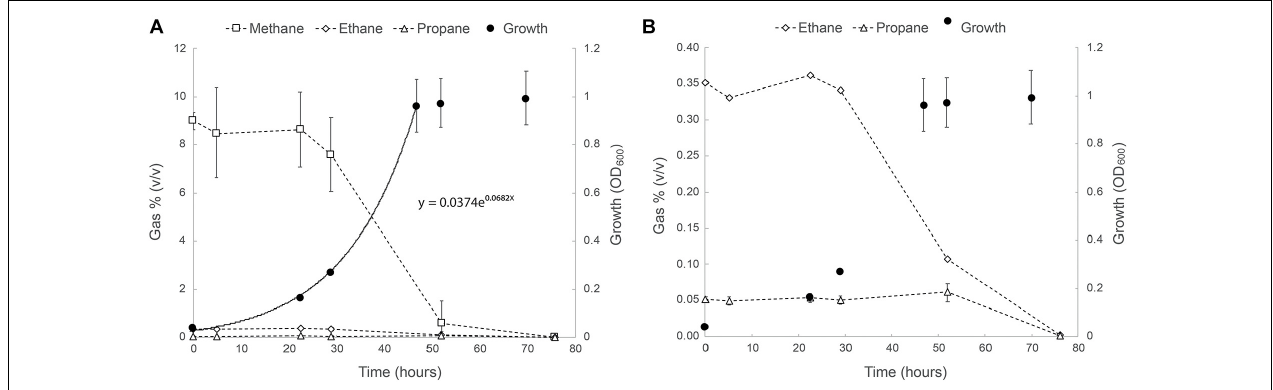
FIGURE 1 | (A) Growth of strain SolV on natural gas (75% CH 4 , 3% C 2 H 6 , and 0.5% C 3 H 8 ). (B) Close up of the ethane and propane consumption profiles in the same experiment. The data points are the average of three biological replicates. Error bars represent the standard deviation. Where not visible, error bars are smaller than the